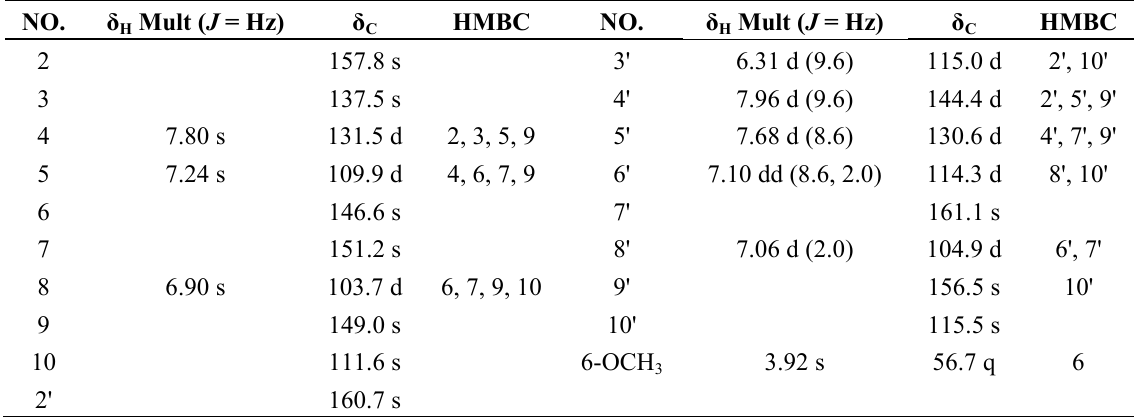
COCD (600 MHz for 1 H, 150 MHz for 13 3 3